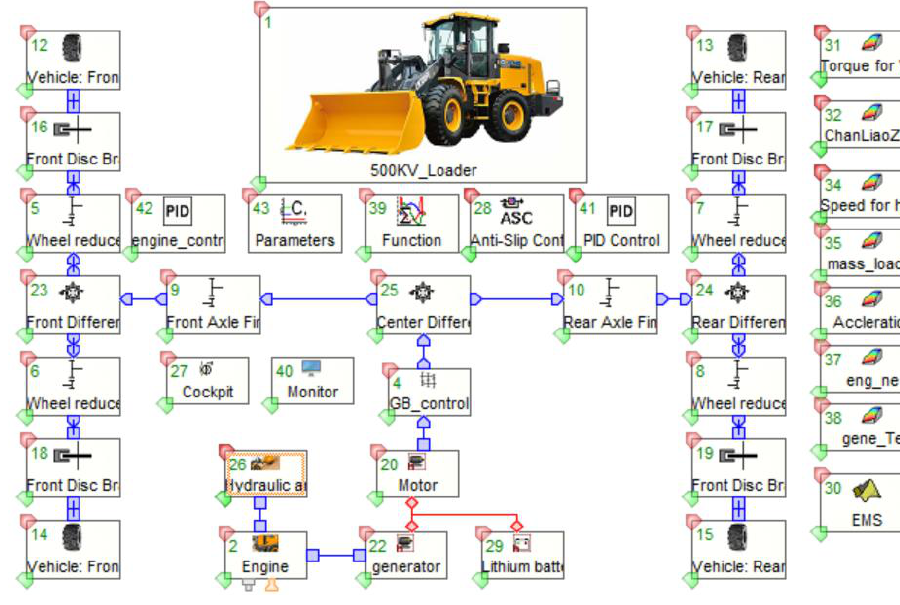
Figure 13. The vehicle model of a series oil–electric HL.